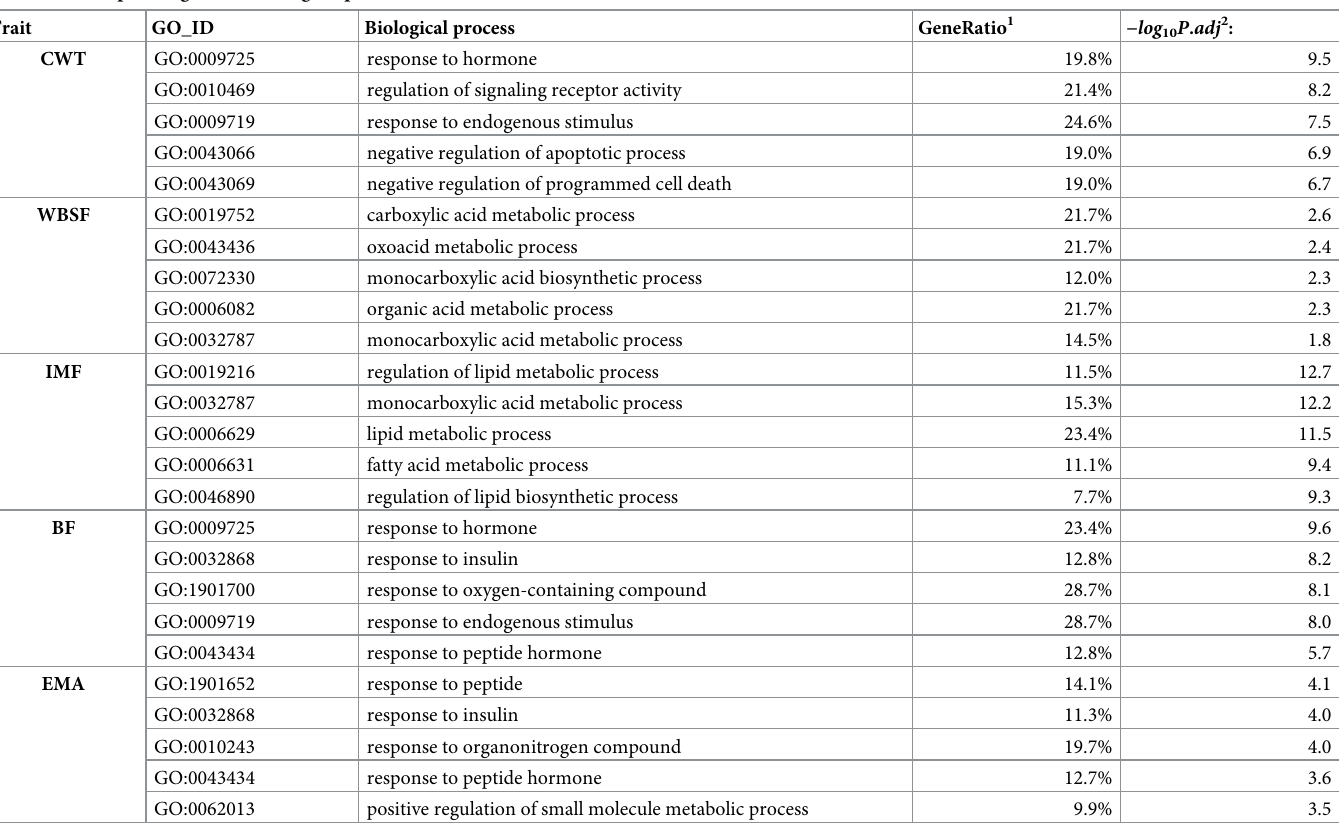
Table 3. The top five significant biological processes for each trait.